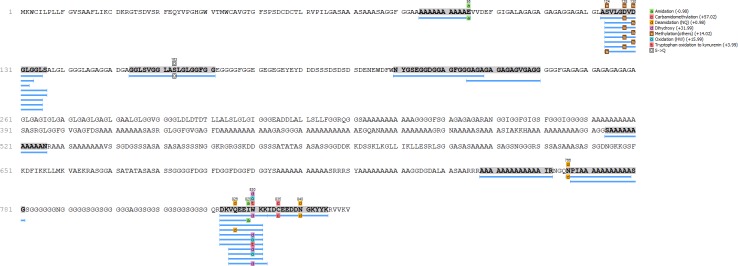
PesB - Hic74 coverage.